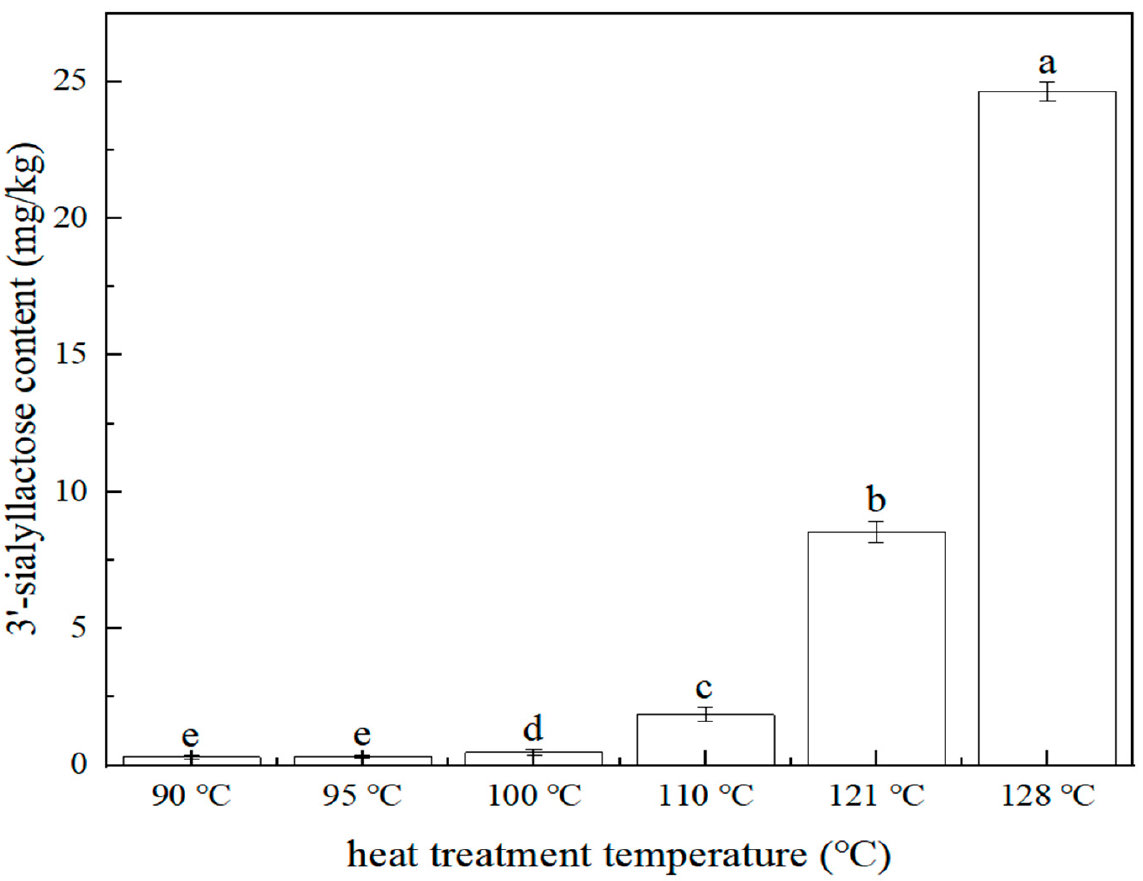
Figure 5. Relationship between 3 (cid:48) -sialyllactose content and heat treatment temperature ( n = 2, p < 0.05). The same letter means no significant difference at the 0.05 level, while different letters mean significant difference at the 0.05 level. The average value of the largest group is labeled as (a), and the groups with significant differences increase alphabetically according to the average size, as be- low.